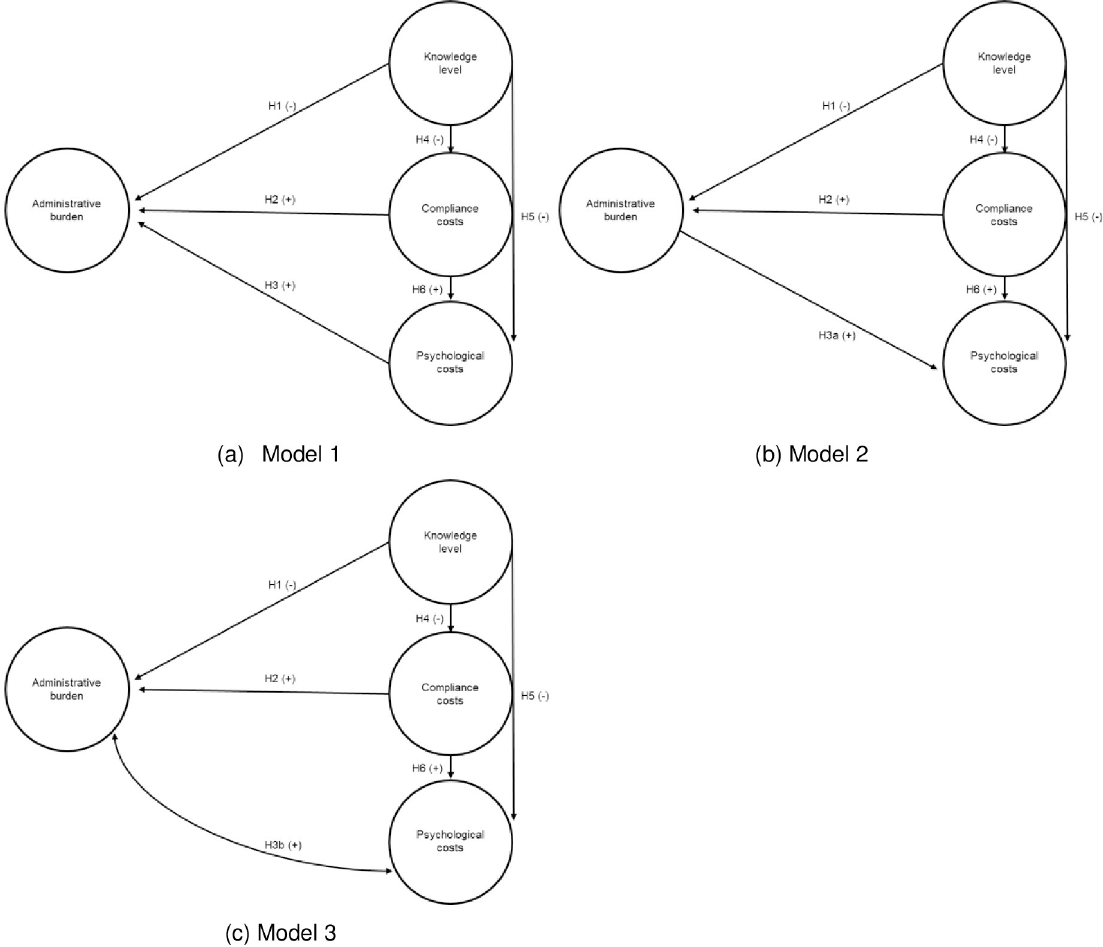
Fig 1. The three conceptual